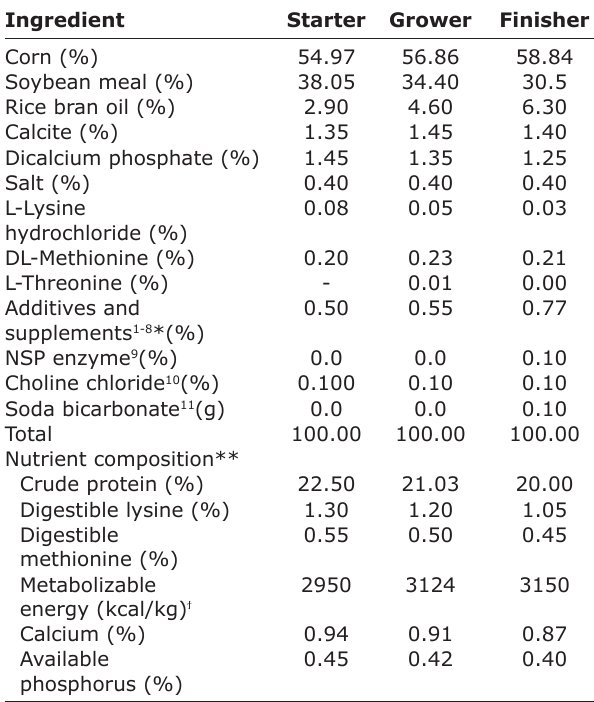
Table-1: Ingredients and nutrient composition of experimental broiler starter, grower, and finisher diets.